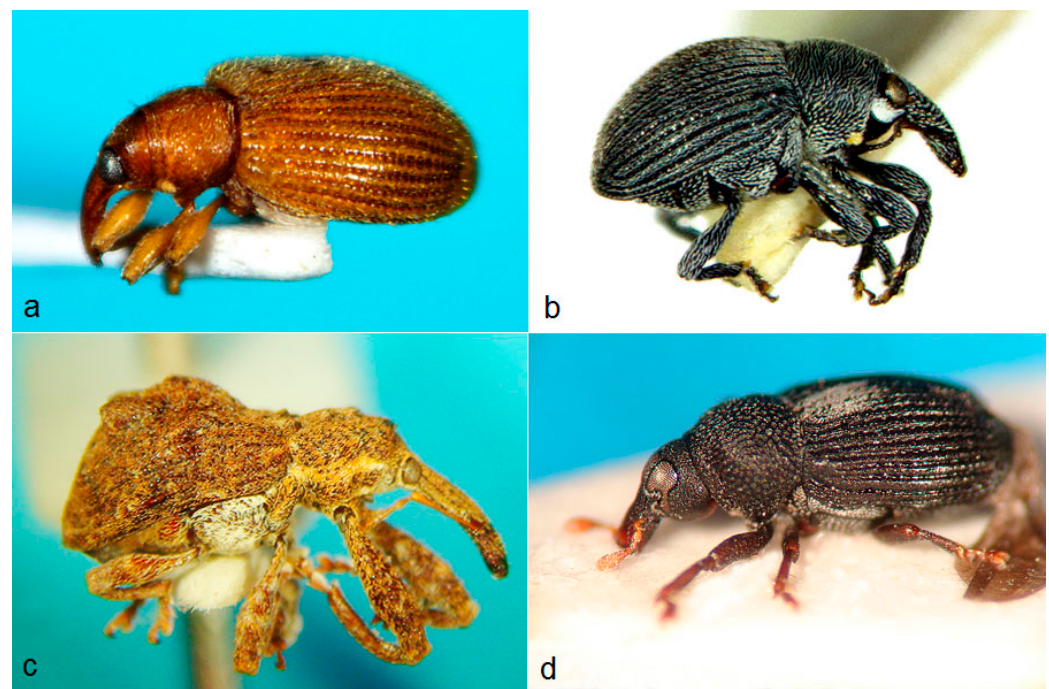
Figure 7. Endaenidius sp. (Ochyromerini) ( a ); Sphinxis sp. (Anoplini) ( b ); Anthonomus ( Tachypterellus ) (Anthonomini) sp. ( c ); the only recorded Laemosaccini species (Mesoptiliinae) with remarkable eye shape ( d